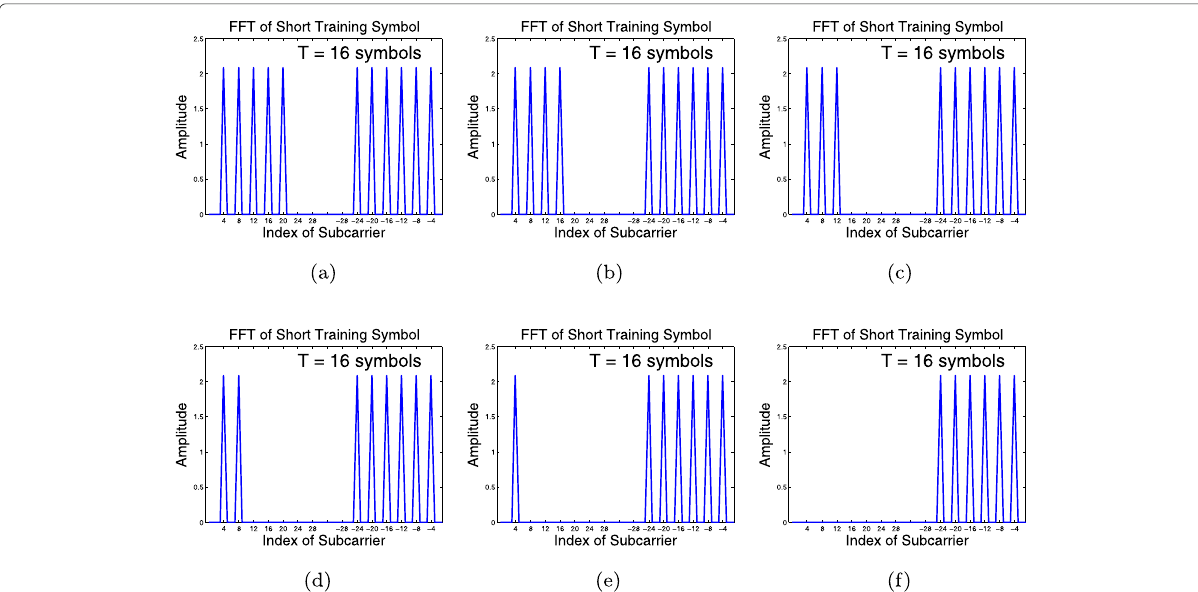
Fig. 6 Observation 2: filtering some consecutive subcarriers out does not change the period of STS. a Filter subcarrier no. 24. b Filter subcarrier no. 20 and 24. c Filter subcarrier no. 16, 20, and 24. d Filter subcarrier no. 12, 16, 20, and 24. e Filter subcarrier no. 8, 12, 16, 20, and 24. f Filter subcarrier no. 4, 8, 12, 16, 20, and 24